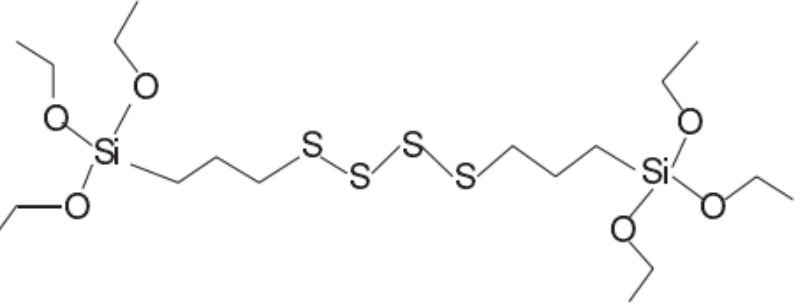
Figure 3. Chemical composition and molecular structure of TESPT.